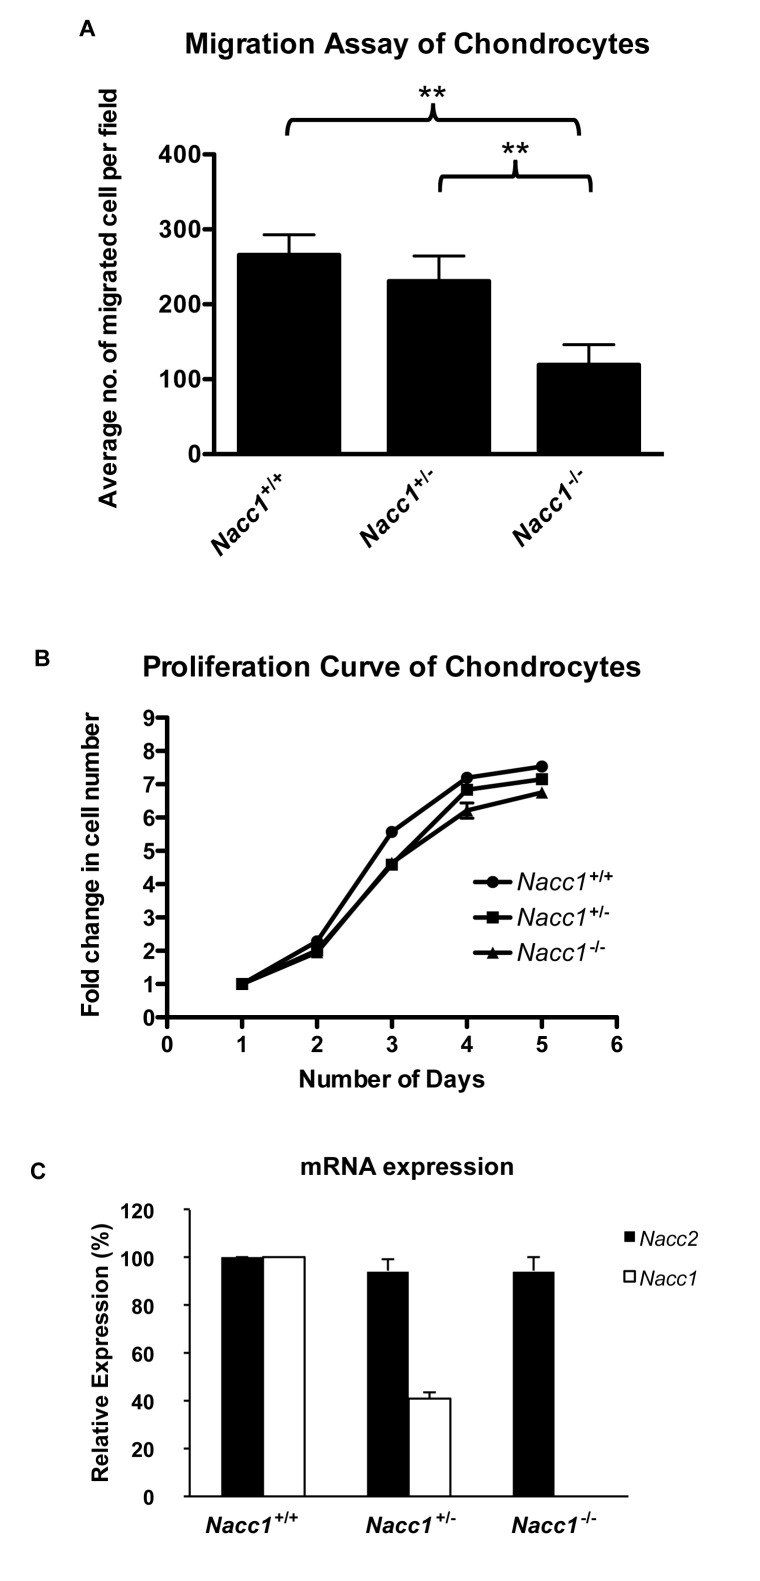
Reduced NAC1 expression decreases chondrocyte migration but does not affect chondrocyte proliferation or the balance of NAC2 expression.Comparison of cultured costal chondrocytes derived from Nacc1+/+ (wild type), Nacc1+/- (heterozygous), and Nacc1-/- (knockout) mouse pups at postnatal day 1 (P1) with respect to their migratory (A) and proliferative (B) properties and their complements of NAC1 and NAC2 (a protein closely related to NAC1, C). A: ** denotes a significant difference in cell migration, p < 0.01). B: Nacc1 depletion did not affect chondrocyte division. C: Real-time quantitative PCR analysis showed that levels of Nacc2 in chondrocytes of Nacc1-/- mice were not altered to compensate for the reduction in Nacc1.